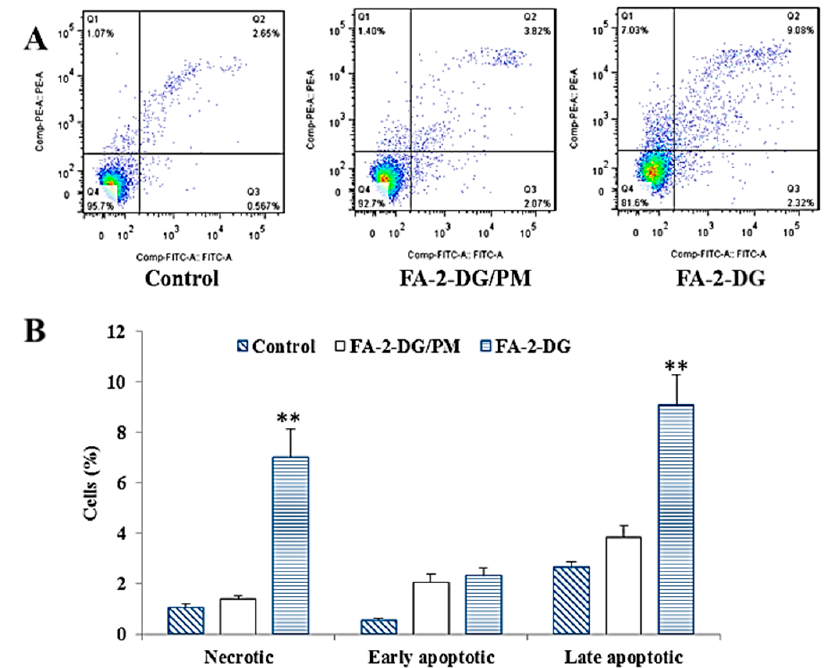
Figure 5. The effect of FA-2-DG on apoptosis in SKOV-3 cells. ( A ) The cells were treated with the blank control and the other two groups of compounds at concentrations of 400 μ M for 48 h, then stained with Annexin V and PI. ( A ) The effect of FA-2-DG on cell death was determined via Annexin V-FITC/PI analysis by using flow cytometry. The representative results from three independent experiments are shown. ( B ) The results are expressed as means ± SD of three independent experiments. Significant difference from the control was determined by using Student’s t -test (** p < 0.01).